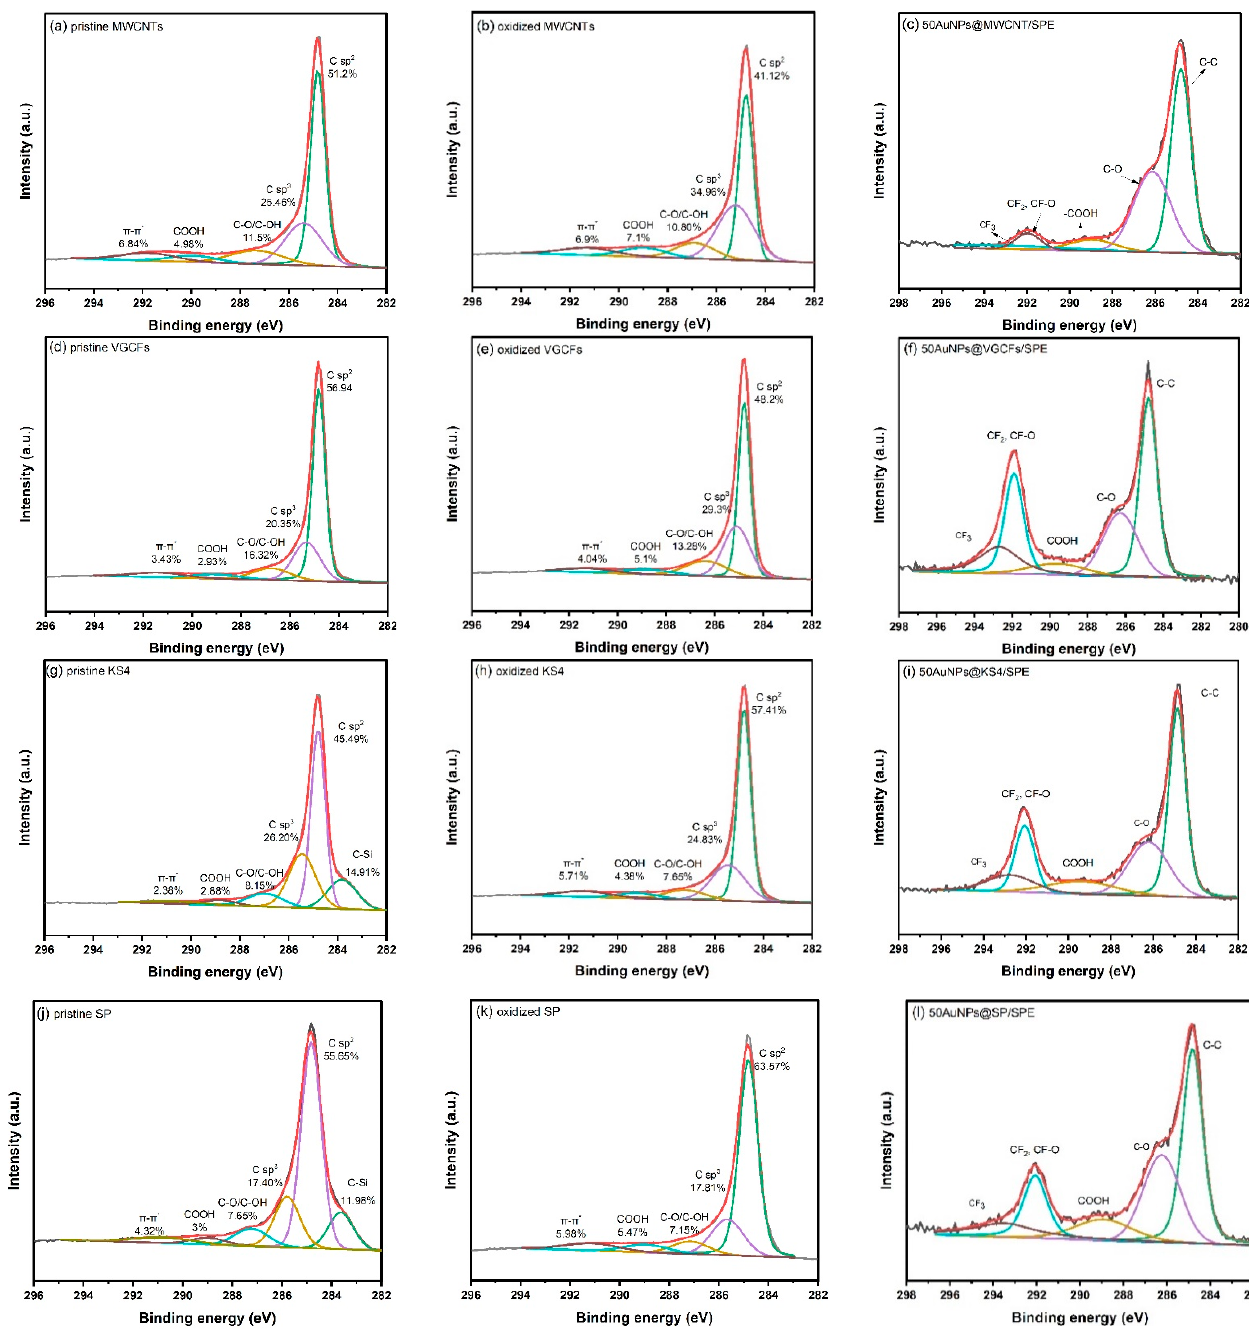
Figure 3. ( a ) XPS spectra of different carbon samples: ( a ) pristine MWCNTs, ( b ) oxidized MWCNTs,